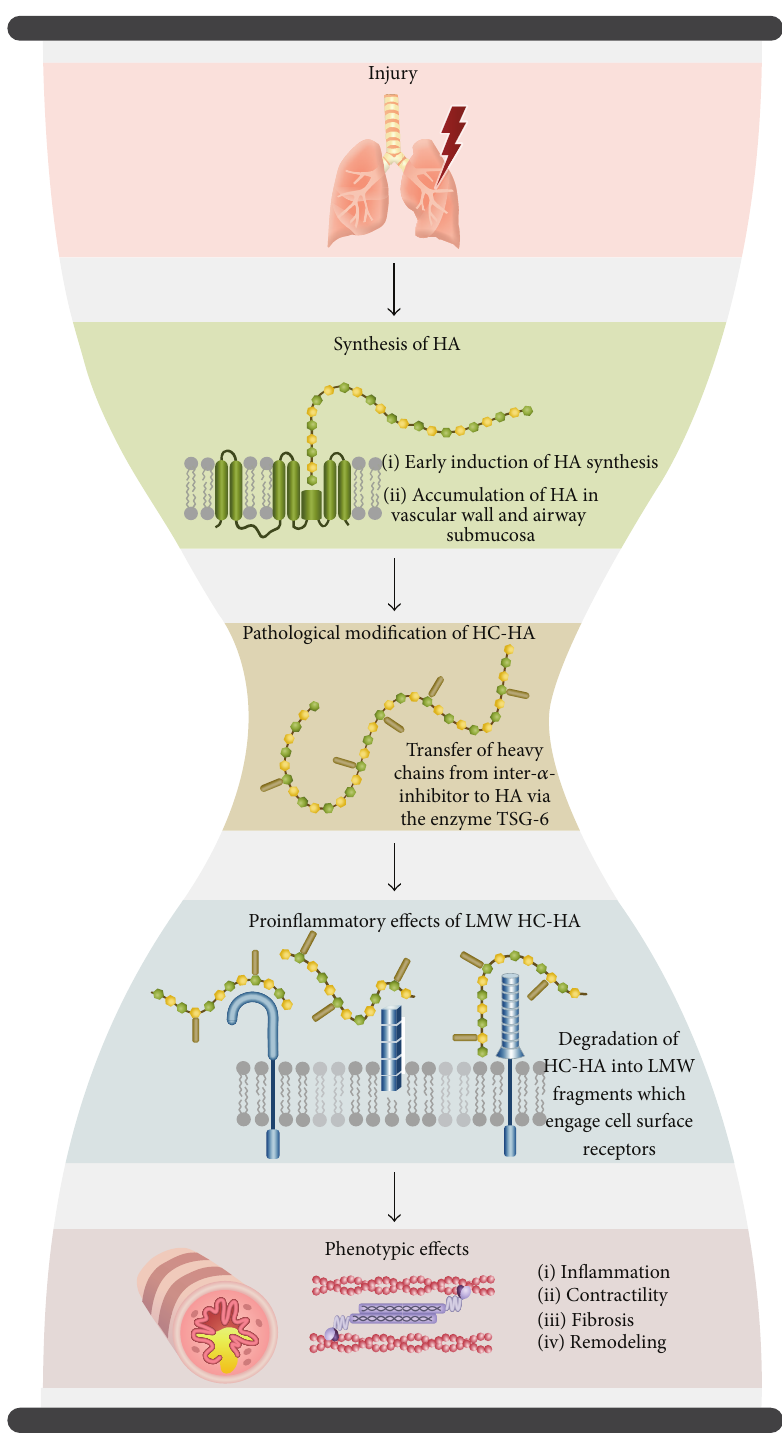
Figure 2: Mechanistic role of HA in the response to lung injury: lung injury leads to the synthesis of HA that accumulates in the peribronchial and perivascular spaces. The ongoing inflammation leads to the generation of heavy-chain-HA (HC-HA) complexes mediated via TSG-6 which is a bottleneck in the pathological transformation of HA matrices. These HC-HA complexes can be degraded into smaller LMW fragments which engage cell receptors such as CD44, TLR4, and TLR2 and create downstream biological effects like fibrosis, AHR, and